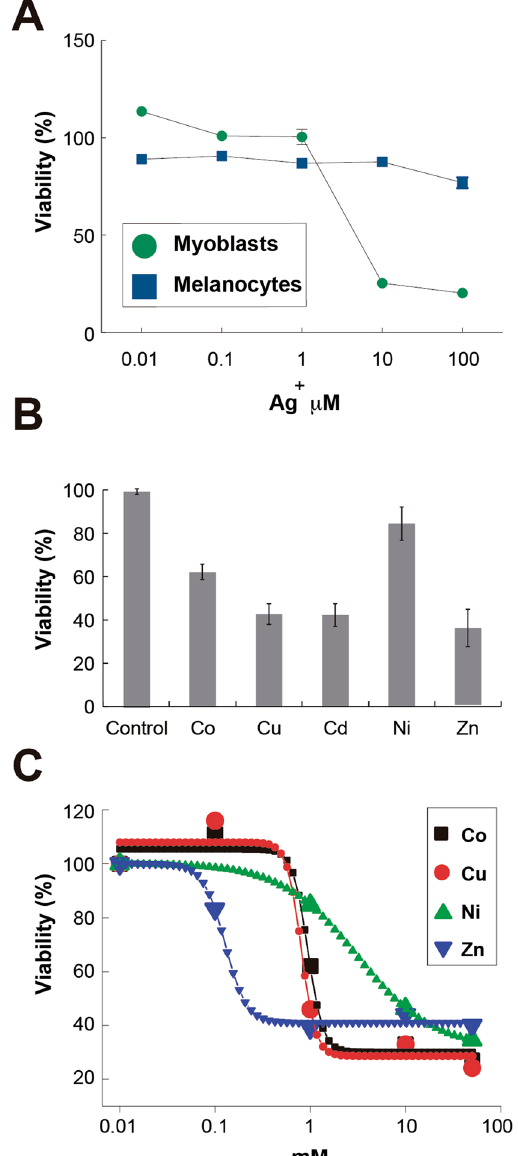
Figure 7. Cytotoxicity effects of Ag and transition metals on H9c2 and B16F10 cells. ( A ) H9c2 and B16F10 cells were treated with Ag at the indicated concentrations for 24 h and viability was determined. ( B ) Effect of transition metals on the viability of cells H9c2. Cells were treated with each transition metal at a concentration of 1 mM for 48 h and viability was determined. Bars represent means of three independent experiments and their respective standard deviations. ( C ) Dose-response effect of transition metals on the viability of H9c2 cells. Cells were treated with transition metals at the stated concentration for 48 h before viability was determined. Indicator points represent means of three independent experiments and their respective standard deviations. Values are mean ± SD (n = 3 experiments at least for each